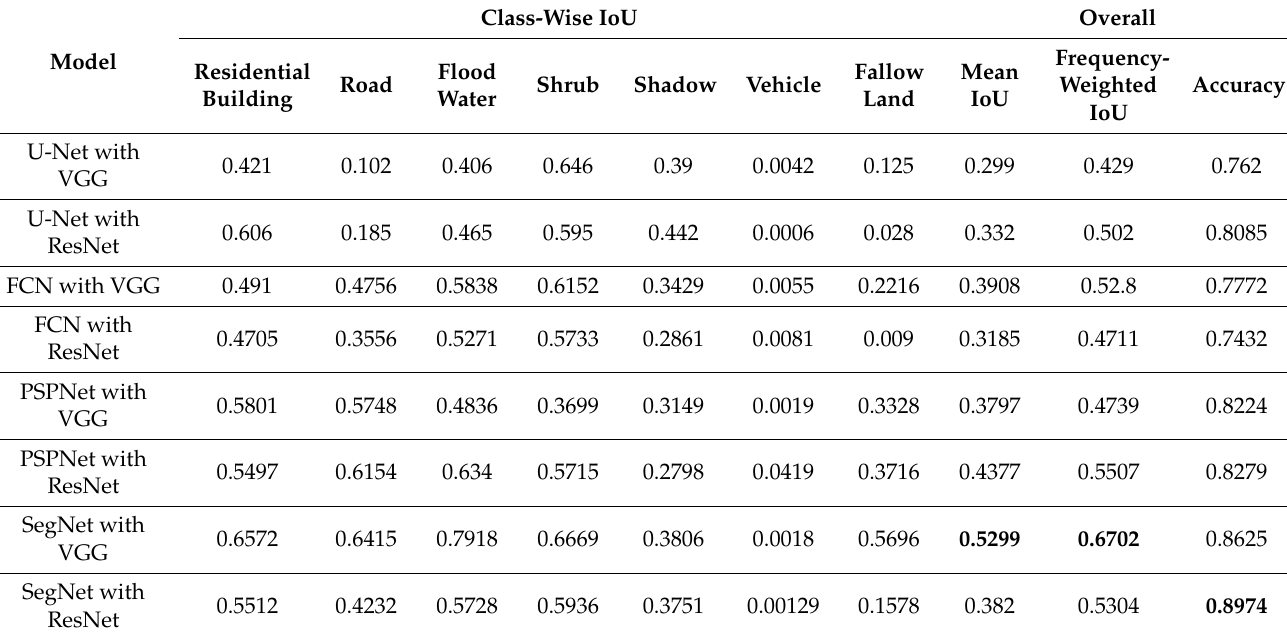
Table 1. Class-wise and overall evaluation of the deep-learning-based multi-class segmentation over urban-floods remote sensing